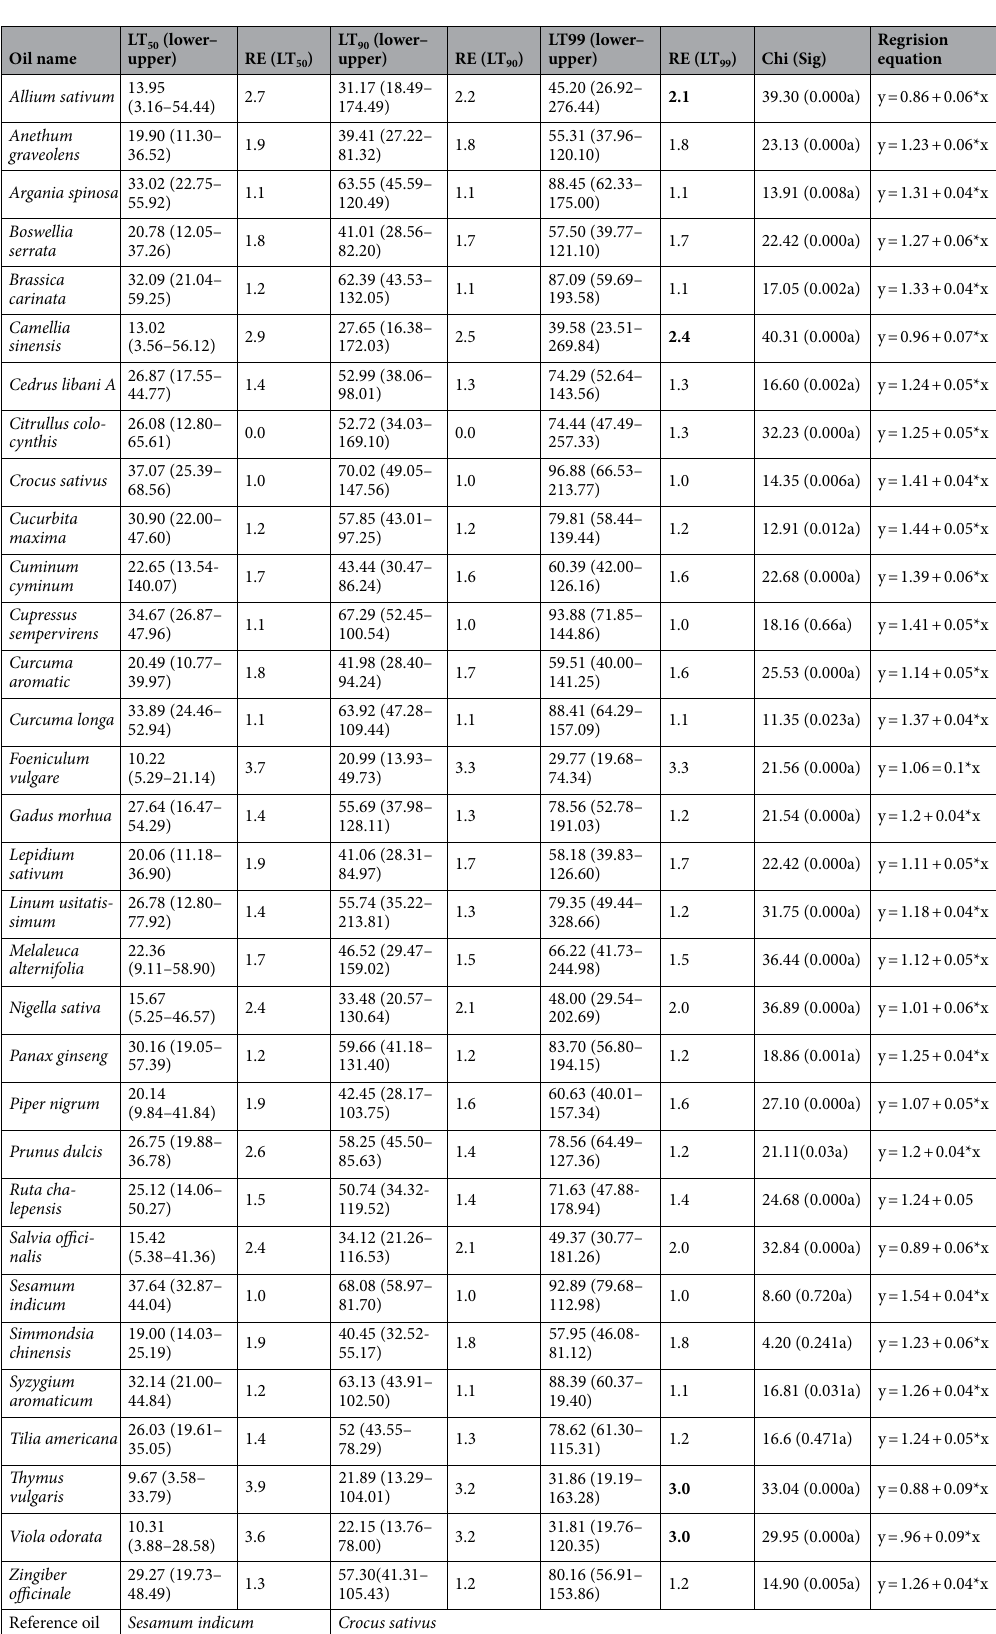
Table 3. Lethal time values of applied oils (1000 ppm) against Culex pipiens larvae. RE Relative efficacy. Significant values are in